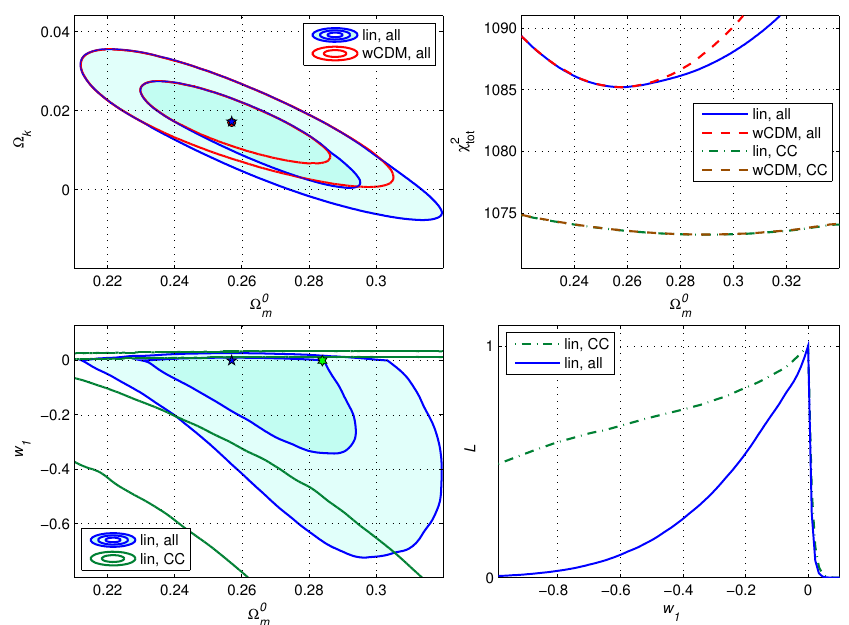
Figure 1. For the linear model (3), 1 σ , 2 σ contour plots in the left panels (“all” means all H ( z ) data); one-parameter distributions χ 2 tot ( Ω 0 m ) and likelihood functions L ( w 1 ) in the right panels are compared with the w CDM model. The stars and circles denote positions of χ 2 tot minima points. − w In the Ω 0 1 plane (the bottom-left panel) we see that for both models, minima m of χ 2 are achieved near w 1 = 0. It is also shown in the bottom-right panel, where the tot likelihood